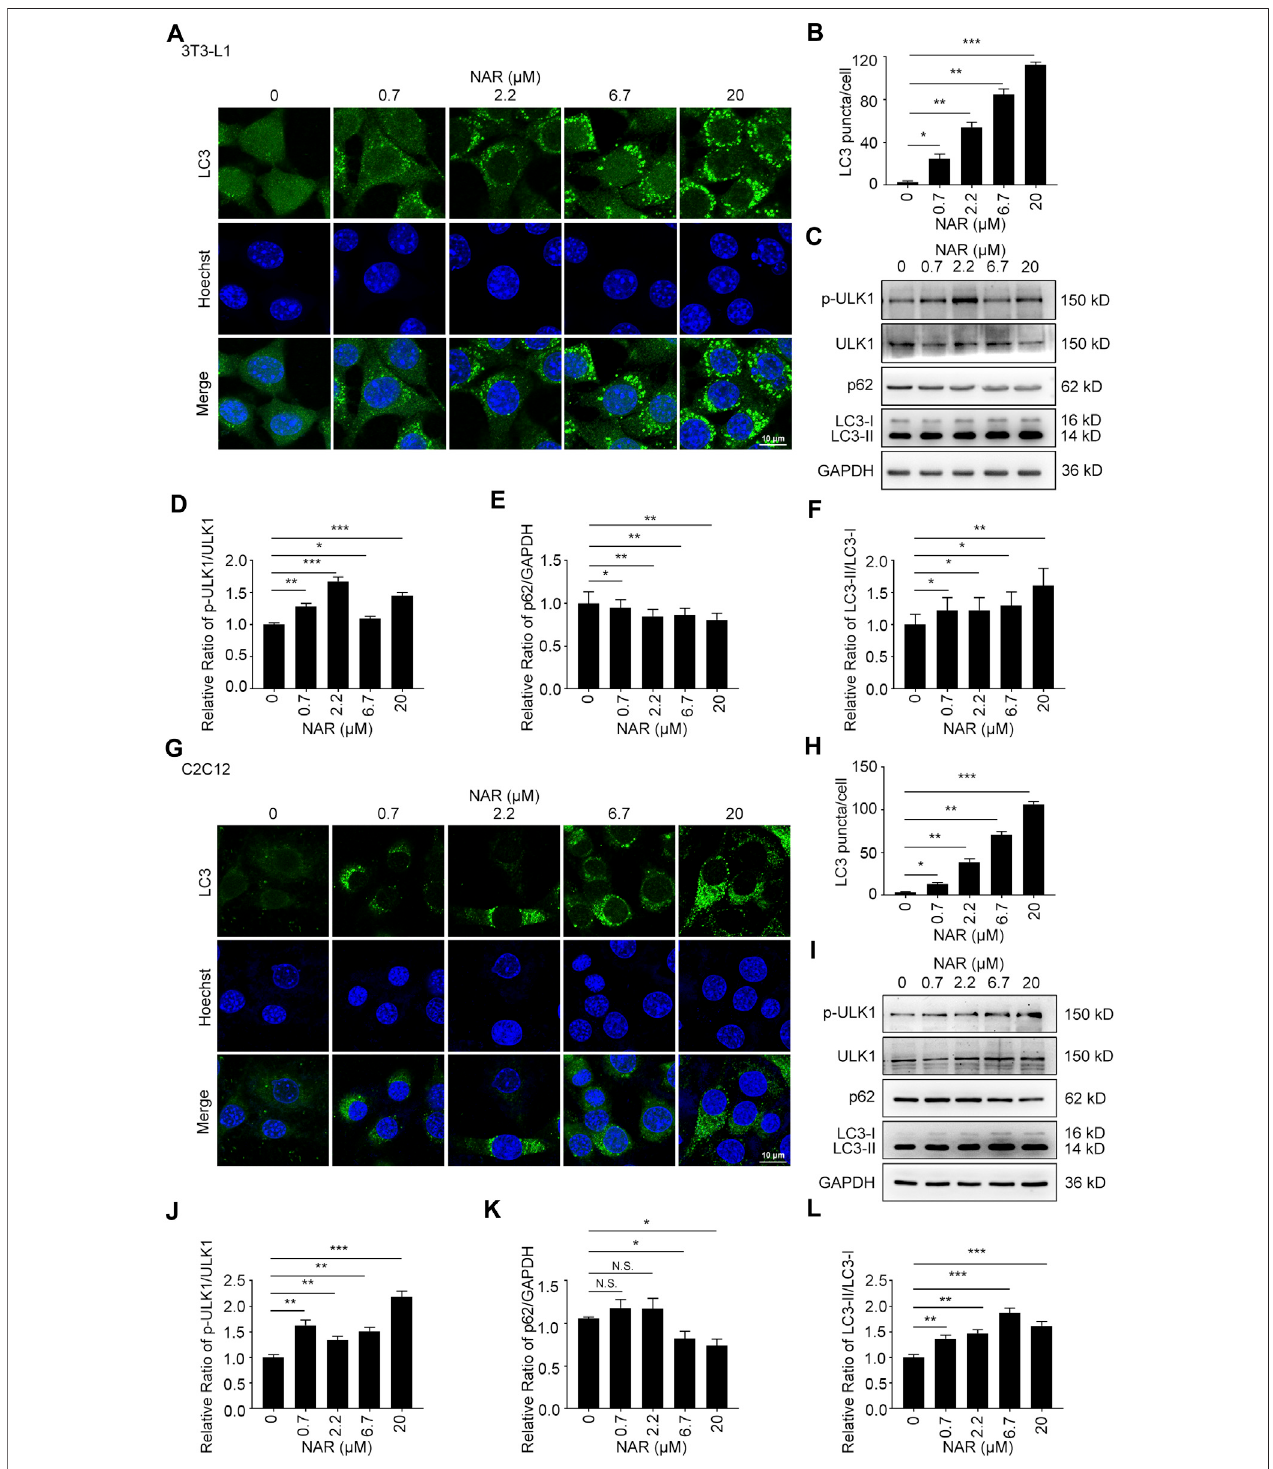
FIGURE 5 | NAR induces autophagy in 3T3-L1 preadipocytes and C2C12 myoblasts. LC3 in 3T3-L1 preadipocytes (A,B) and C2C12 myoblasts (G,H) were detected by immuno fl uorescence (endogenous LC3 puncta, green), and pictured by confocal microscopy (the objective ampli fi cation 63 × ). The expression of p-ULK1, ULK1,p62,andLC3in3T3-L1preadipocytes (C – F) andC2C12myoblasts (I – L) wasdetectedbyWesternblotting.Barsrepresent10 μ M.Allvalueswereexpressedas the mean ± SD from three or more independent experiments. *** p < 0.001; ** p < 0.01; * p < 0.05 vs . untreated cells.; Abbreviation: NAR, naringenin; ULK1, unc-51 like autophagy activating kinase 1; p-ULK1, phosphor-ULK1; p62, ubiquitin-binding protein p62; LC3, microtubule-associated protein 1A/1B-light chain 3.